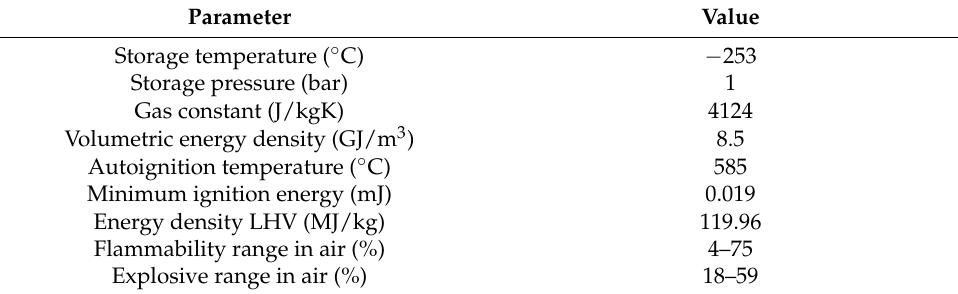
Table 1. Liquefied hydrogen